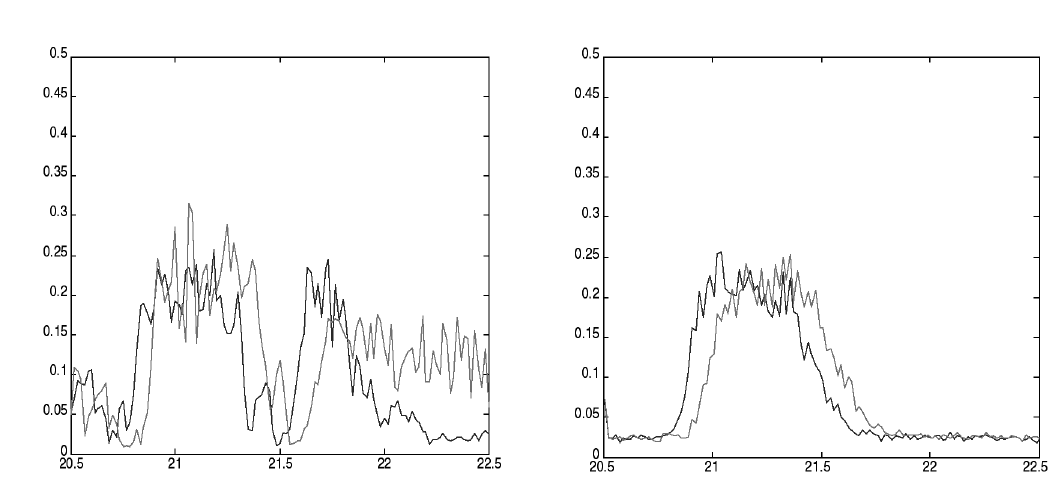
Fig. 9. Measurement vs modelling for propagation through a